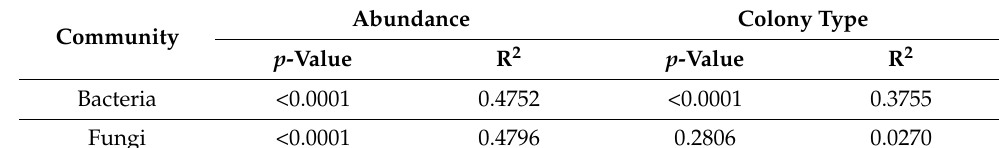
Table 1. Correlation between blight severity and endophyte culture complexity.